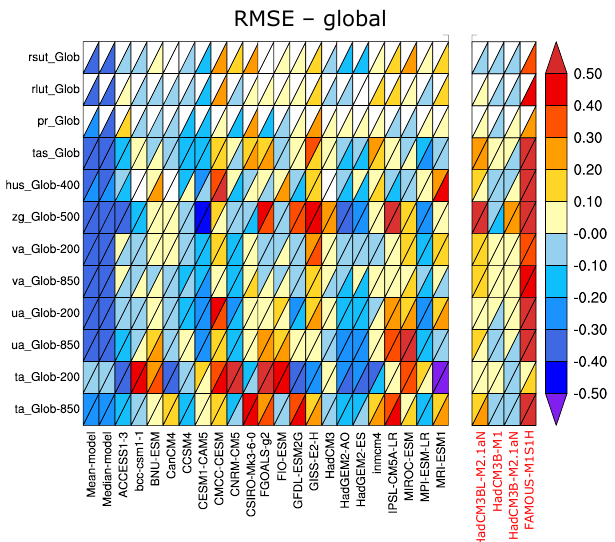
Figure 2. Relative error measure of the CMIP5 models (21 in total; in black) and the BRIDGE models (4 in total; in red) performance. Error measure is calculated from a time–space root-mean square error (RMSE) of contemporary and predecessor CMIP5 model his- torical climatological (1980–2005) seasonal cycle simulations and BRIDGE pre-industrial seasonal cycle climatologies against obser- vations (1980–2005) for a set of nine different atmospheric vari- ables. Error for each individual variable is characterised as a relative error by normalising the result of the median error of all model re- sults (Gleckler et al., 2008); the BRIDGE models are not included in the mean/median error. For instance, a value of 0.20 indicates that a model’s RMSE is 20% larger than the median CMIP5 error for that variable, whereas a value of − 0.20 means the error is 20% smaller than the median error. The diagonal split grid square shows the rel- ative error for the reference observed/reanalysis dataset (lower right triangle) and the alternative dataset (top left triangle). White trian- gles/boxes indicate where no data were available. Evaluated global atmospheric variables are TOA outgoing all-sky short-wave radia- tion (rsut_Glob), TOA outgoing all-sky outgoing long-wave radia- tion (rlut_Glob), precipitation (pr_Glob), near-surface temperature (tas_Glob), specific humidity at 400hPa (hus_Glob-400), geopoten- tial at 500hPa (zg_Glob-500), V-wind at 200hPa (va_Glob-200), V-wind at 850hPa (va_Glob-850), U-wind at 200hPa (ua_Glob- 200), U-wind at 850hPa (ua_Glob-850), temperature at 200hPa (ta_Glob-200), and temperature at 850hPa